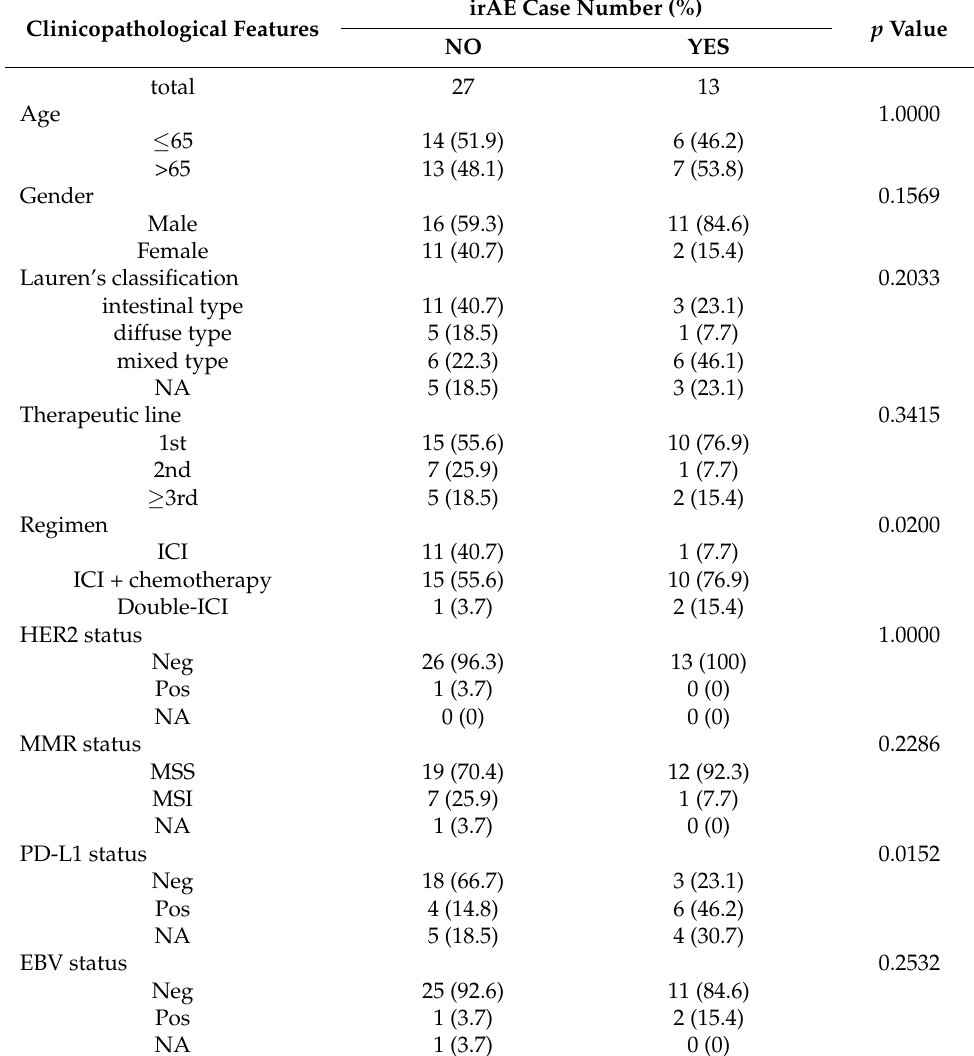
Table 4. Correlation of irAE with clinicopathological features in validating cohort (n = 40). Clinicopathological